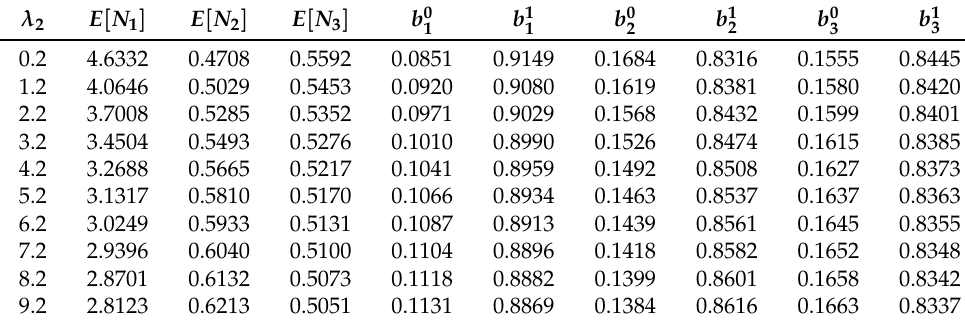
Table 11. Effect of λ 2 on various performance measures.